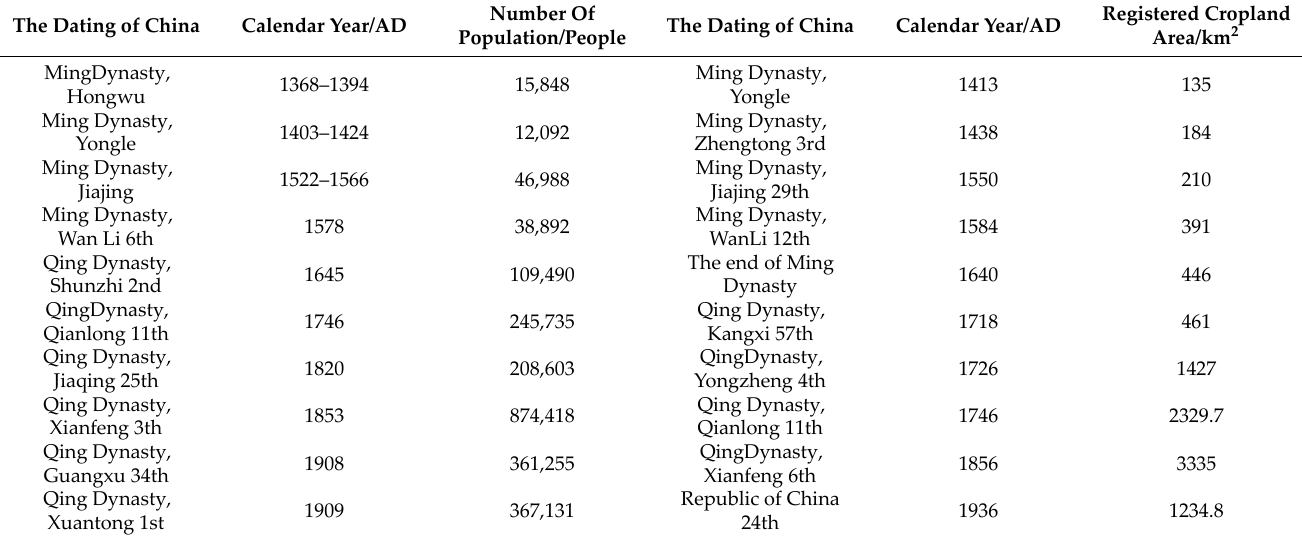
Table 1. Literature records of population and cropland during the Ming and Qing Dynasties